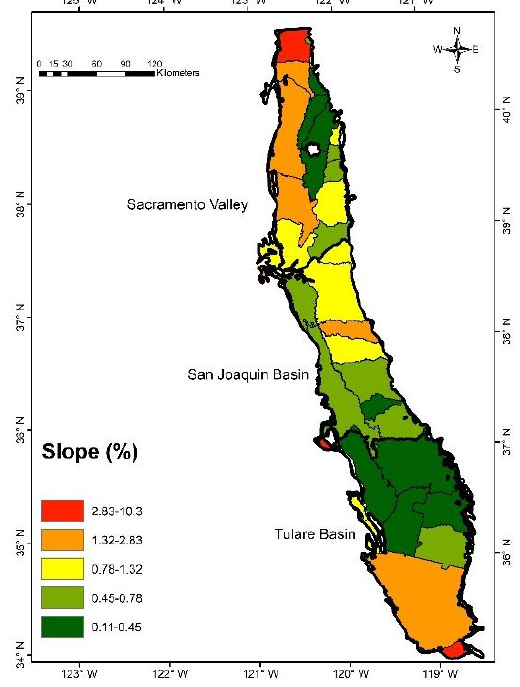
Figure 8. Percent slope in Central Valley.